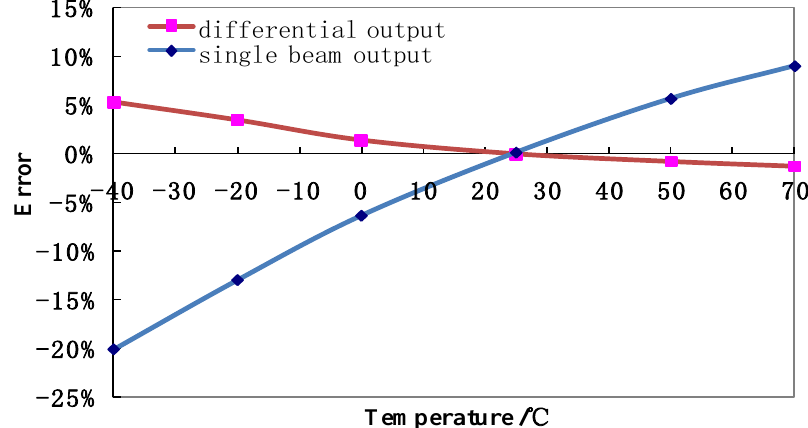
Figure 9. In response to temperature changes, the quantified errors using the differential frequency output were about four times smaller than the values obtained using the single